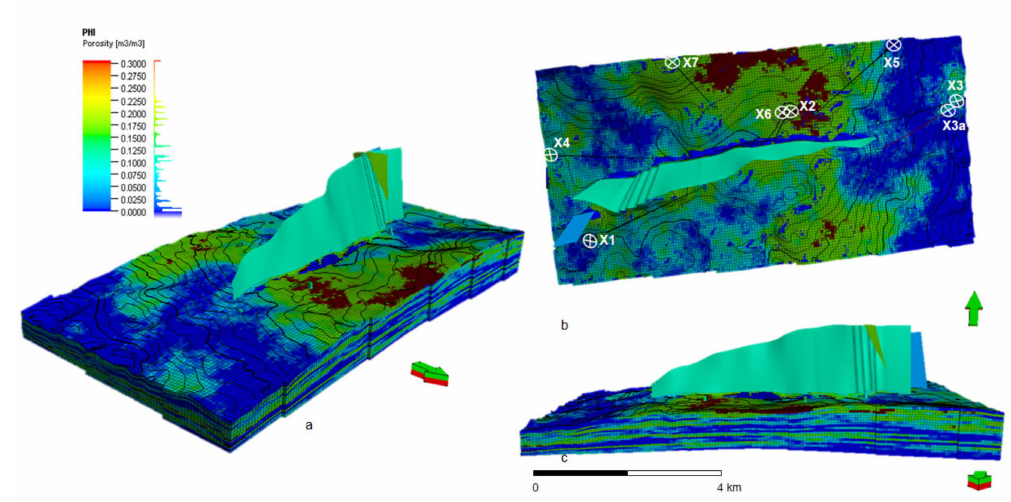
Figure 6. The 3D structural model of the case study reservoir with three main faults. ( a ). Oblique view, ( b ). top map view at depth of 1200 m, and ( c ). east-west cross-sectional view. The model shows the porosity distribution throughout the reservoir area (arrows point